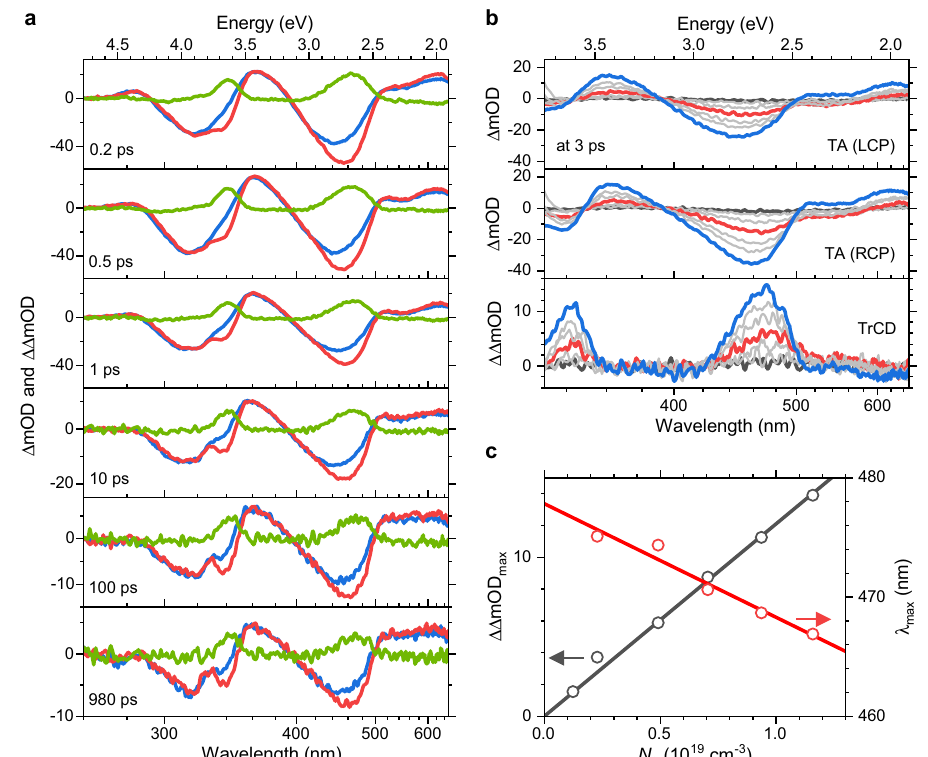
Fig. 4 Ultrafast transient circular dichroism and transient absorption spectra of a 241 nm thin c-PFBT thin fi lm. a Spectra at six different delay times: transient absorption for probing with left-circularly polarised light (blue), right-circularly polarised light (red) and the resulting TrCD spectrum (green). b Fluence-dependent spectra at 3 ps for initial exciton number densities between 5.7 × 10 17 (black) and 1.2 × 10 19 cm − 3 (blue); red line for N 0 = 4.9 × 10 18 cm − 3 ; left-circularly polarised probe light (top), right-circularly polarised probe light (middle) and the resulting TrCD spectrum (bottom). c Correlation of the TrCD peak signal (black circles) and the peak position of the TrCD signal (red circles) with the initial exciton number density including a proportional (black) and a linear (red) fi